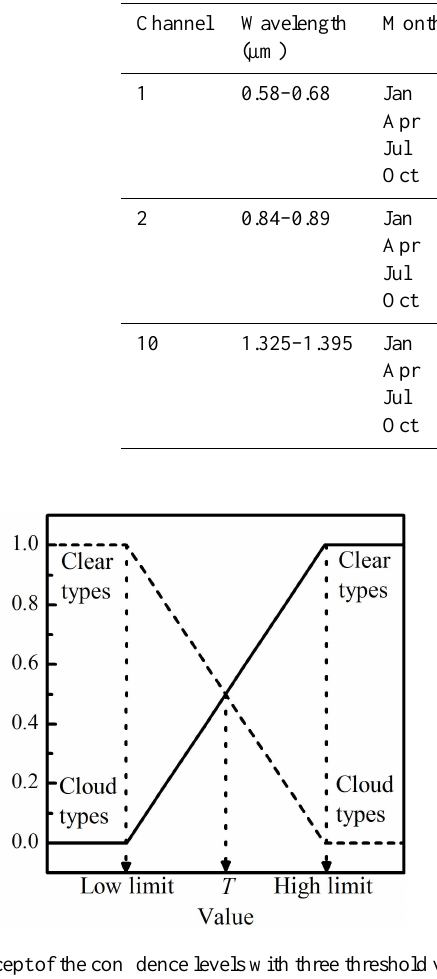
Fig. 1. Concept of the confidence levels with three threshold